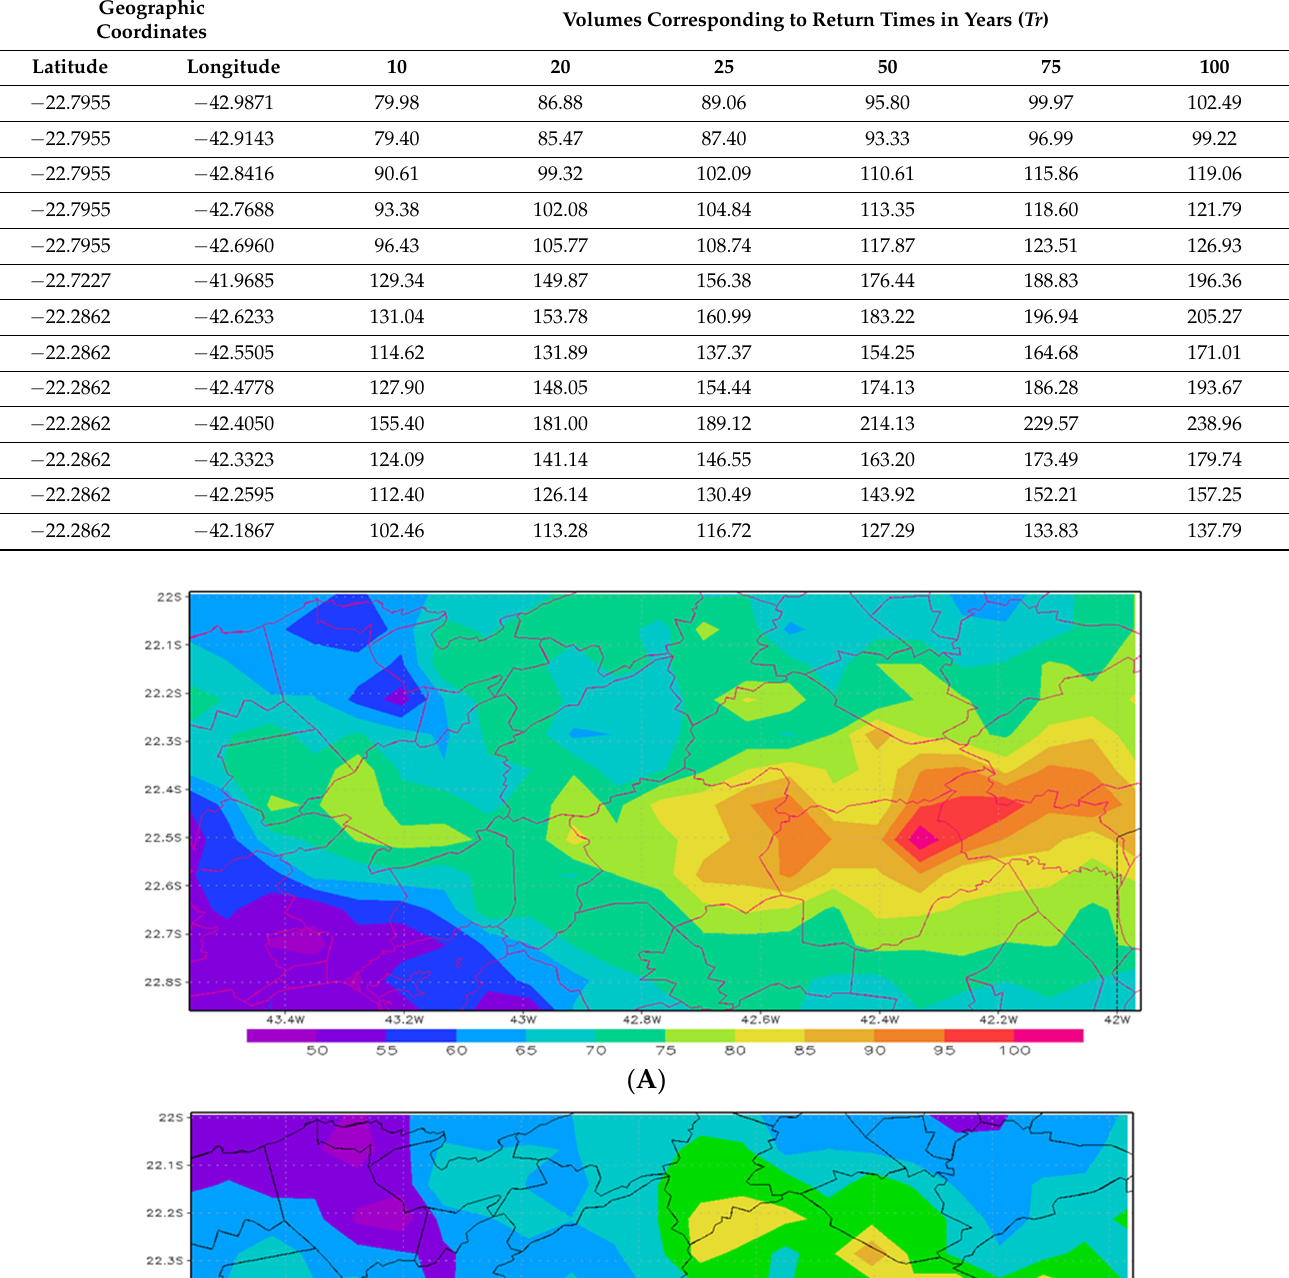
Table 3. Example points. Estimated precipitation values at different return times.